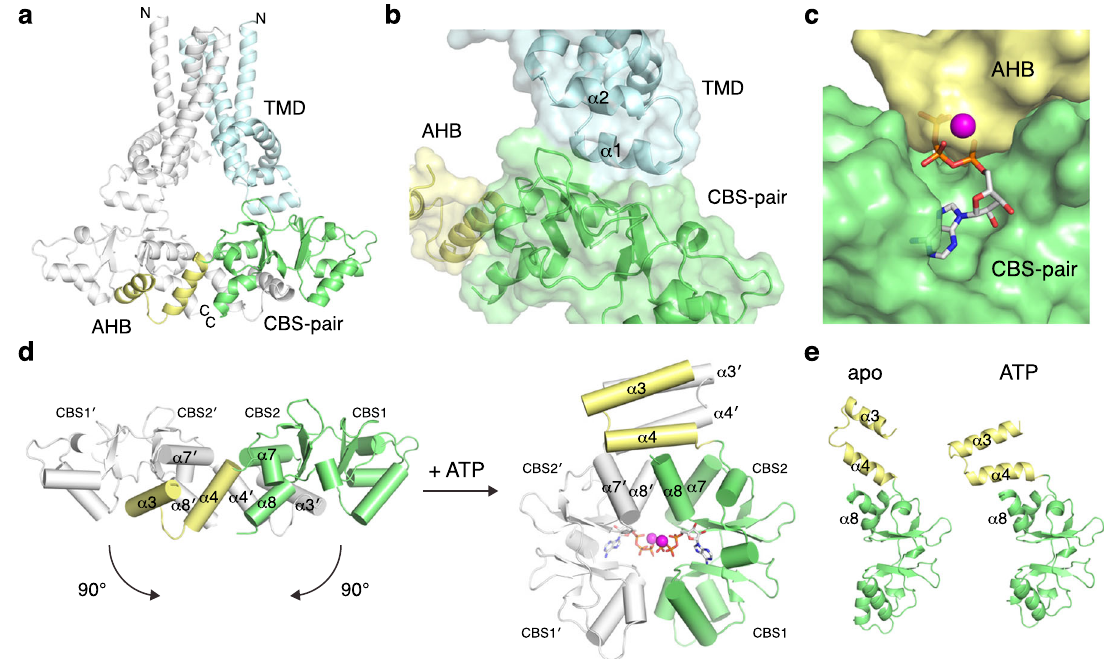
Fig. 5 Apo conformation of MtCorB Δ C captured by R235L mutant. a Overall structure of MtCorB Δ C R235L mutant. One chain is colored by domains. b Novel domain – domain contact between TMD and CBS-pair domain. c AHB binds to CBS-pair domain and competes for Mg 2 + -ATP site. d Large conformational change in the AHB and CBS-pair domains upon Mg 2 + -ATP binding. e The apo and ATP-bound structures are similar with differences limited to the AHB and α 8 helix.